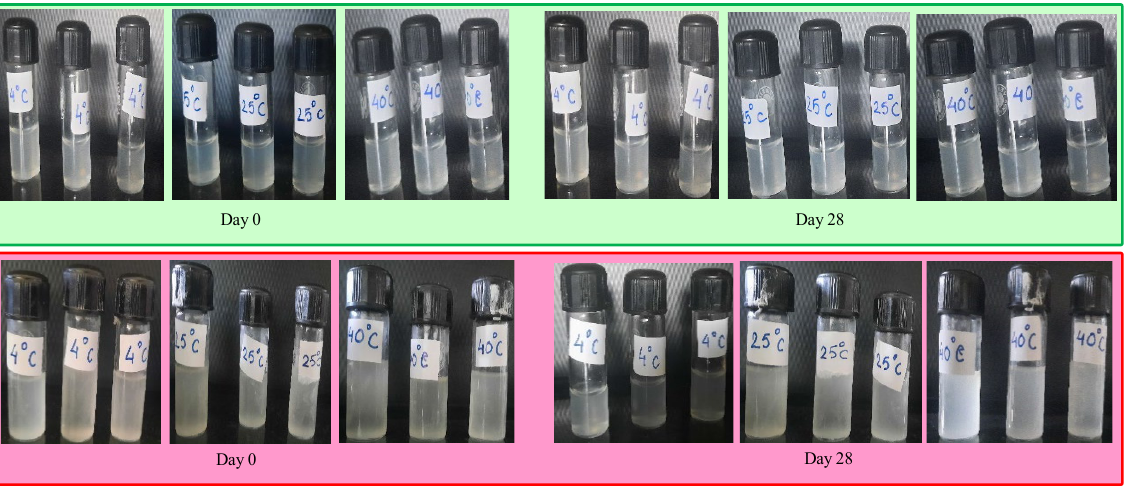
Figure 8. Physical stability of VCZ-MA-NPs (Green Box) and VCZ-MP-NPs (Pink Box) at three different temperatures (4°C, 25°C, and 40°C). No significant changes were observed in terms of color change, turbidity, or drug precipitation during the one month stability study.